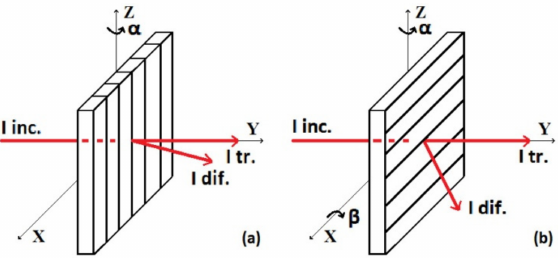
Figure 2. Schemes for measuring the diffraction efficiency: ( a ) Scheme 1 and ( b ) Scheme 2. Iinc., Itr., Idif. are directions of incident, transmitted, and diffracted beams, respectively; α is the angle of rotation of the grating around the Z axis; β is the angle of rotation of the grating around the X